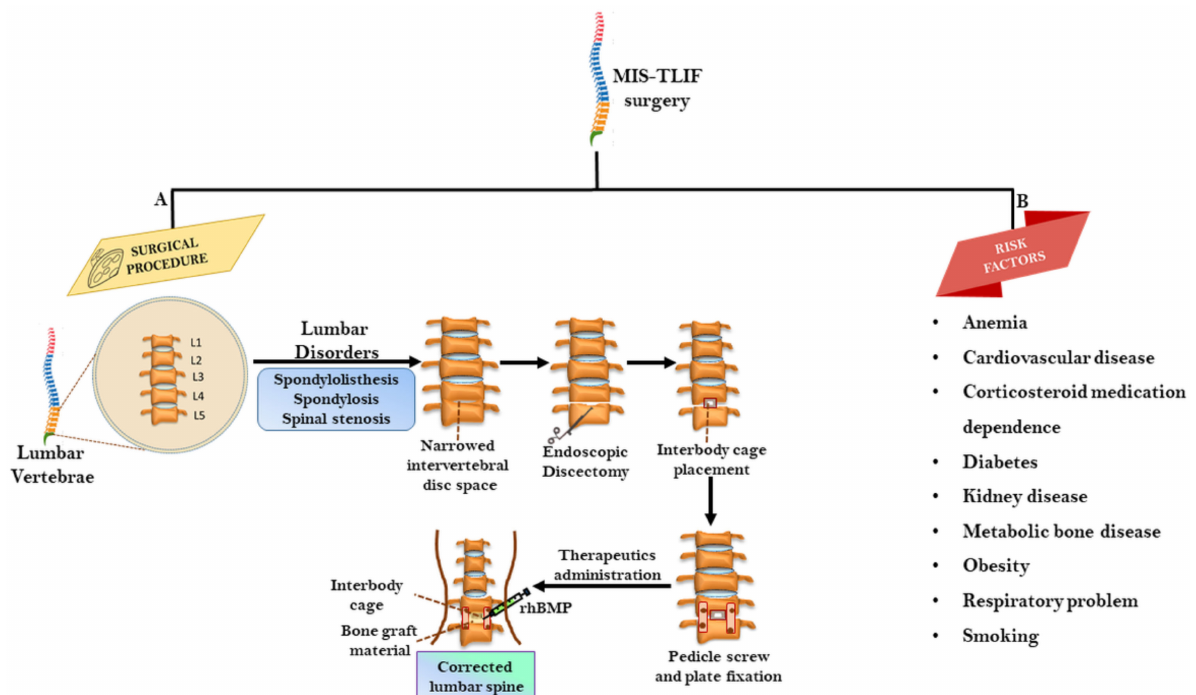
Figure 1. Overview of MIS-TLIF surgery. ( A ) The surgical procedure for correcting lumbar spinal disorders, which includes endoscopic discectomy, interbody cage placement, pedicle screw and plate fixation and administration of therapeutic rhBMP or bone graft material ( B ) Risk factors limiting TLIF surgery involves anemia, cardiovascular disease, corticosteroid medica- tion dependence, diabetes, kidney disease, metabolic bone disease, obesity, respiratory complications an smoking. MIS-TLIF: minimally invasive transforaminal lumbar interbody fusion, rhBMP: Recombinant human bone morphogenetic